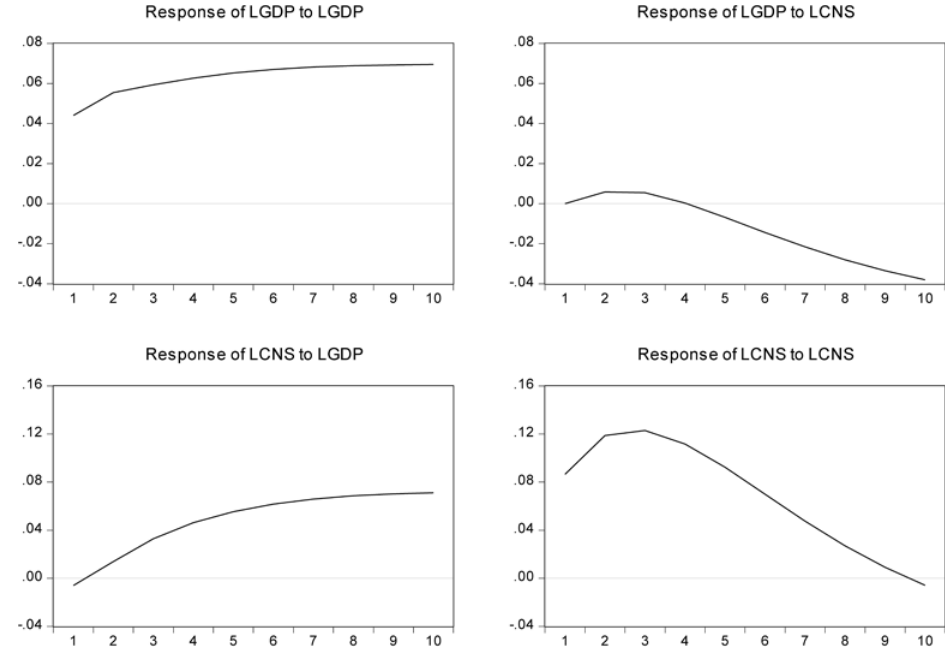
Figure 2 Response to Cholesky One S.D.